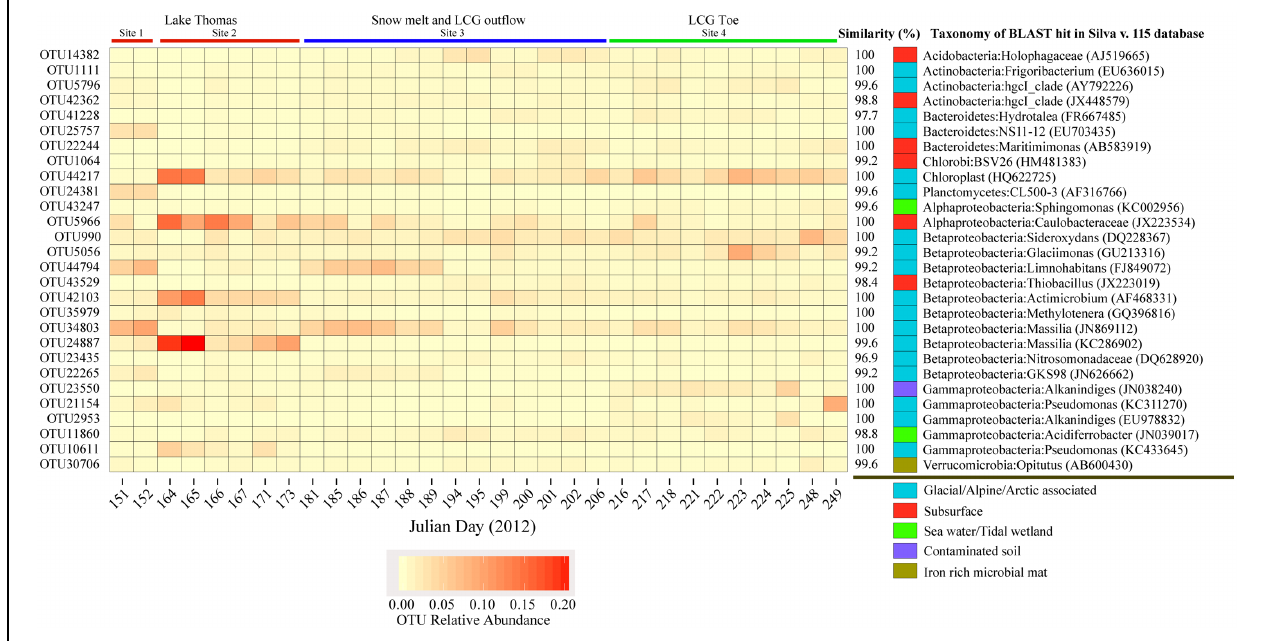
FIGURE 3 | Heatmap depiction of the relative abundance of the top OTUs, their putative taxonomy and closest match from Silva v. 111 NR SSU database. Blast hits were chosen based on alignment length and similarity.